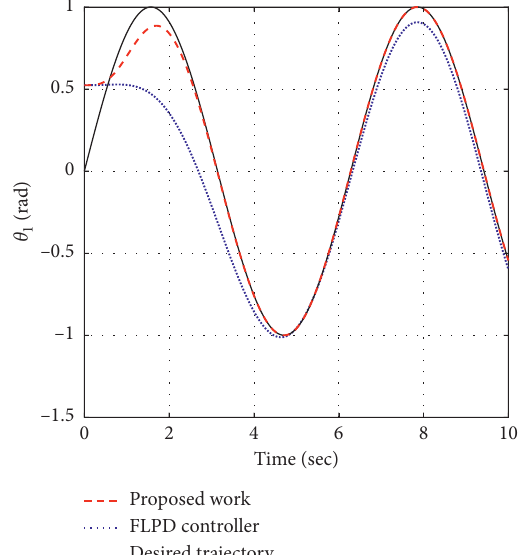
Figure 8: Trajectory tracking of the joint angle for the flexible link.